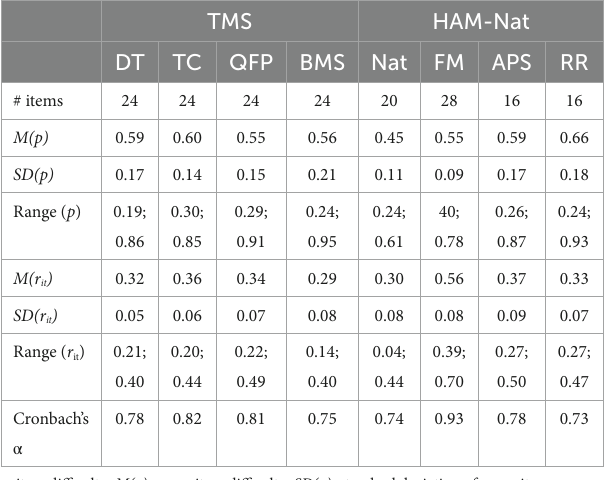
Figural matrices (FM): The items of this subtest are 3 × 3 matrices filled with geometric symbols that follow certain design rules (e.g., symbols in the first and second cell of a row add up in the third cell). The last cell of the matrix is left empty, and respondents have to select the symbols which logically complete